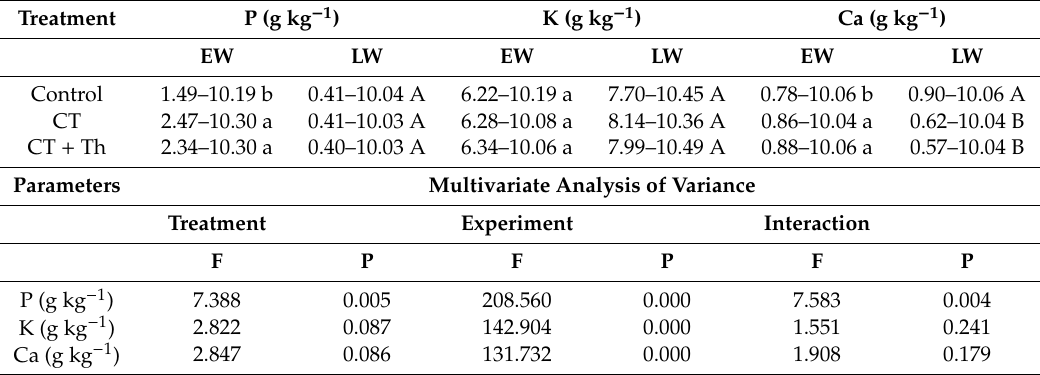
Table 3. Influence of different compost tea (CT) treatments on baby spinach tissue nutrient content in both experiments. Values are the mean + SD; n = 3). Control: sprayed distilled water (12 m 3 per ha); CT: sprayed compost tea (12 m 3 per ha); CT + Th: sprayed compost tea (12 m 3 per ha) and T. harzianum T-78 (5 × 10 8 cfu mL − 1 per ha). EW: early winter; LW: late winter. Different lowercase letters indicate differences between treatments ( p ≤ 0.05) in EW and different uppercase letters indicate differences between treatments ( p ≤ 0.05) in LW.